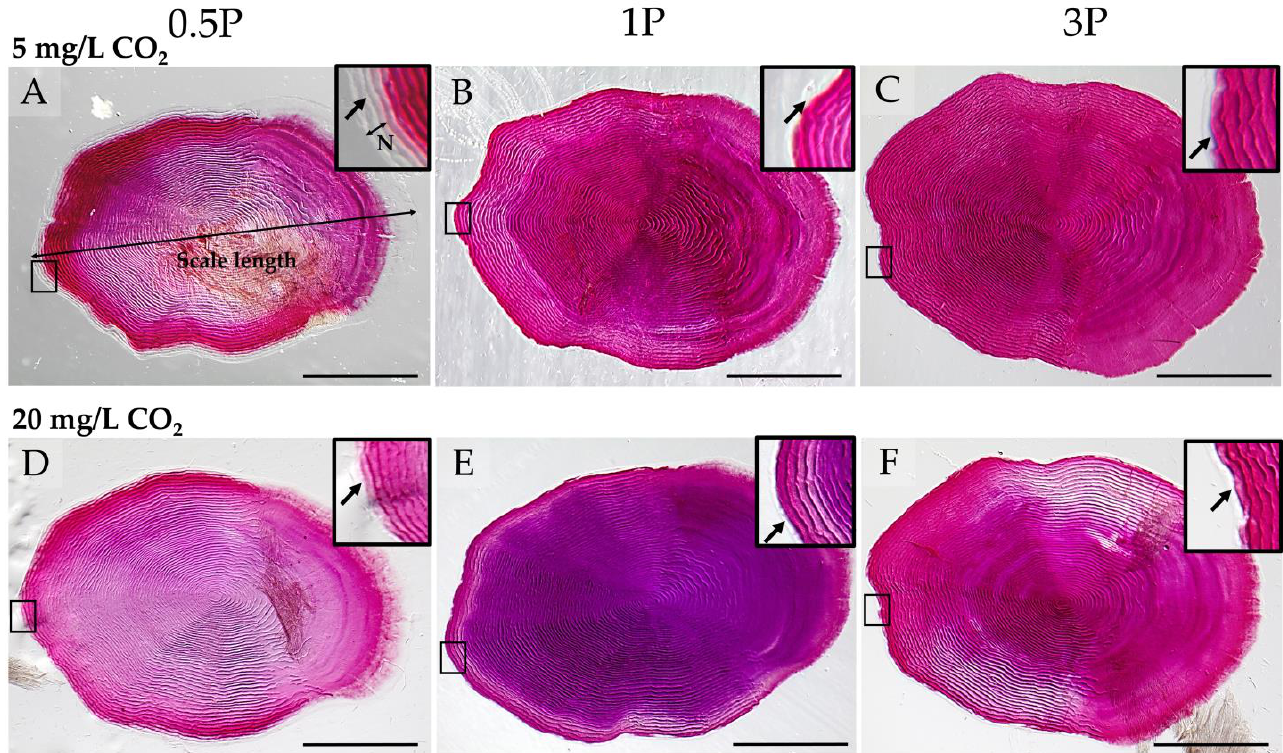
Figure 3. Scale morphometry. Representative samples of scales stained with Alizarin Red S from animals fed different levels of total phosphorus (P) 0.5P (6.3 g/kg) ( A , D ), 1P (9.0 g/kg) ( B , E ), and 3P (26.8 g/kg) ( B , F ), and reared in conditions with no CO 2 injected (5 mg/L) ( A – C ) or with injected CO 2 (20 mg/L) ( D – F ). Red staining represents the mineralized part of the scale ( A – F ) while the non-mineralized area of the scale (N) (black arrows in rectangles in A – F ) remains unstained. Total length (L) of the scale is indicated ( A ).